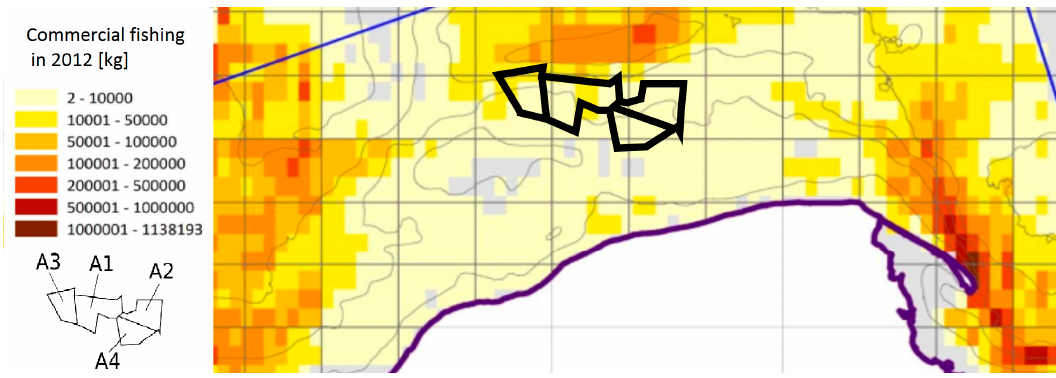
Figure 5. The decision variants against the background of the fishing areas.